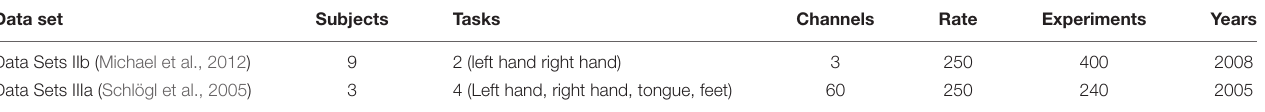
TABLE 1 | Data set introduction.